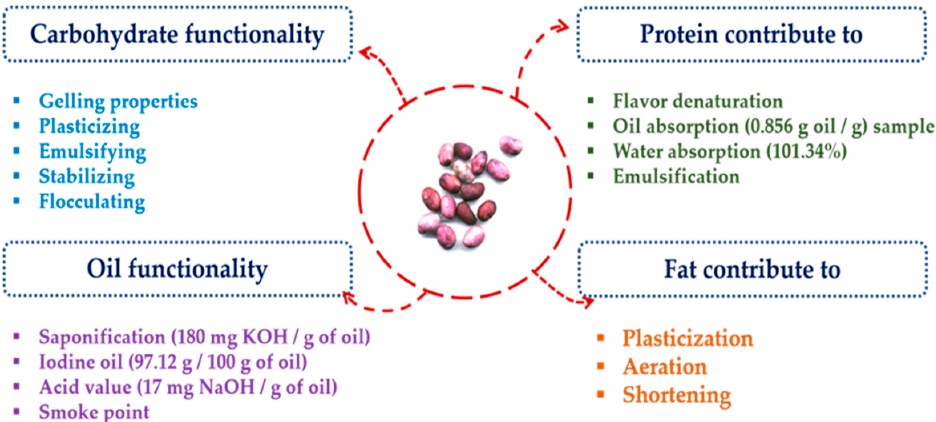
Figure 1. Jamun seed functional food properties.